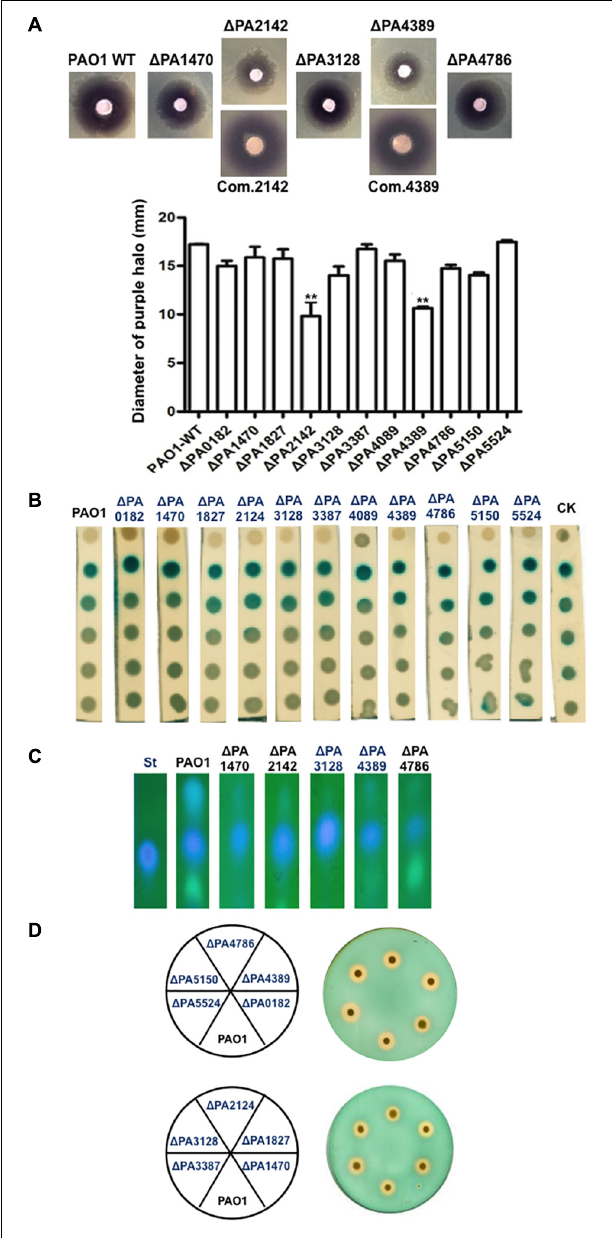
FIGURE 2 | Detection of quorum-sensing (QS) signals and siderophore produced by P. aeruginosa strains. (A) Analysis of the C4-HSL signals produced by P. aeruginosa strains using Chromobacterium violaceum CV026 as reporter strain. (B) Analysis of the 3-oxo-C12-HSL signals produced by P. aeruginosa strains using Agrobacterium tumefaciens reporter strain NTL4 (pZLR4). (C) The amount of PQS produced by P. aeruginosa strains was compared by direct UV illumination of culture supernatant extracts separated by normal-phase TLC on silica 60 F 254 plates. (D) Siderophore secretion in P. aeruginosa mutant strains. At least three independent repetitions of each experiment were performed. Black bars represent standard deviations. Pairwise comparisons were made between wild-type strain PAO1 and the OAR mutant strains with Student’s t -test. ∗∗ Significant difference, P < 0.05. PAO1, P. aeruginosa wild type strain; (cid:49) PAxxxx, P. aeruginosa OAR mutant strain; Com.xxxx, (cid:49) PAxxxx strain carrying a plasmid-encoded PAxxxx gene. St, Standard PQS. CK, A. tumefaciens NT1/pTiC58 (cid:49) accR